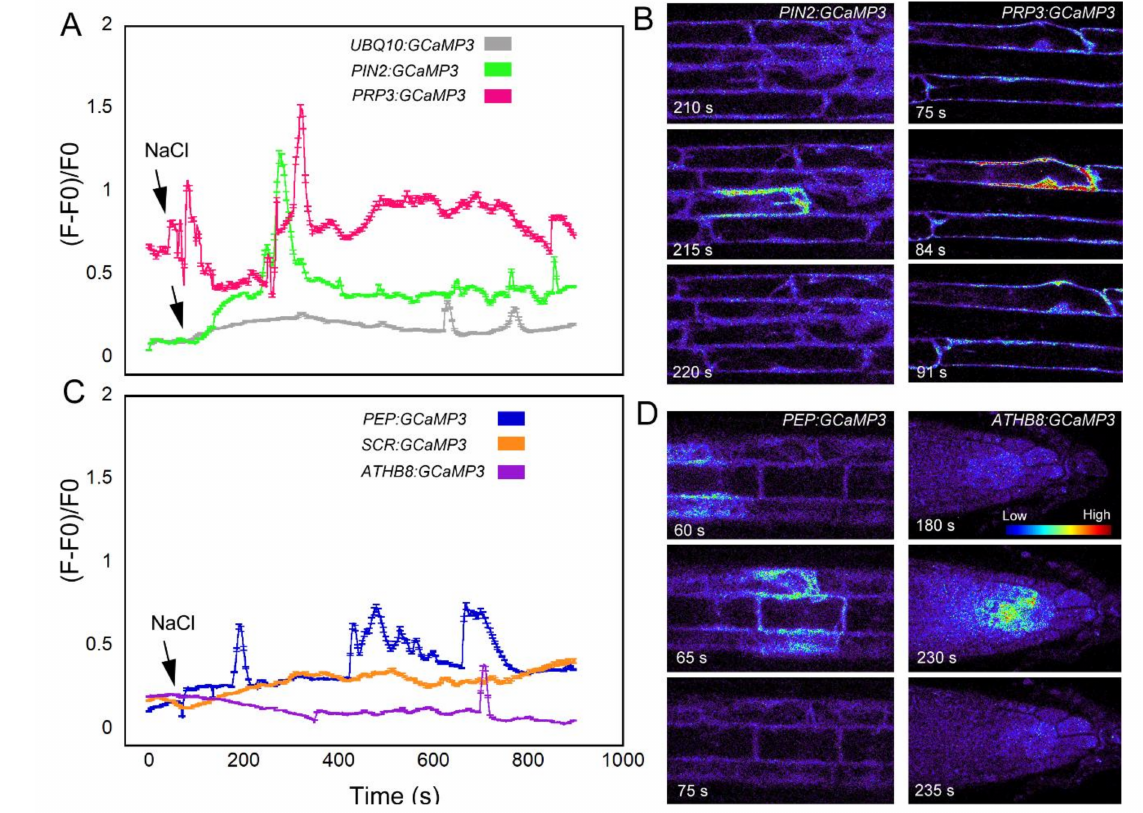
Figure 6. NaCl-triggered [Ca 2 + ] cyt transients in cell type-specific GCaMP3 lines. Time course ( A ) and representative heat maps ( B ) of [Ca 2 + ] cyt transients in roots expressing UBQ10:GCaMP3 and root surface cell-targeted GCaMP3 lines. Time course ( C ) and representative heat maps ( D ) of [Ca 2 + ] cyt transients in roots where GCaMP3 is expressed in interior root cell types. Colors of the line graphs in A and C correspond to the cell types shown in preceding figures. The grey line shows the time course of UBQ10:GCaMP3 -expressing lines. The arrows indicate time of application of sodium chloride. Intensity bar in panel D correspond to high (red) and low (blue) fluorescence with red indicating elevated [Ca 2 + ] cyt